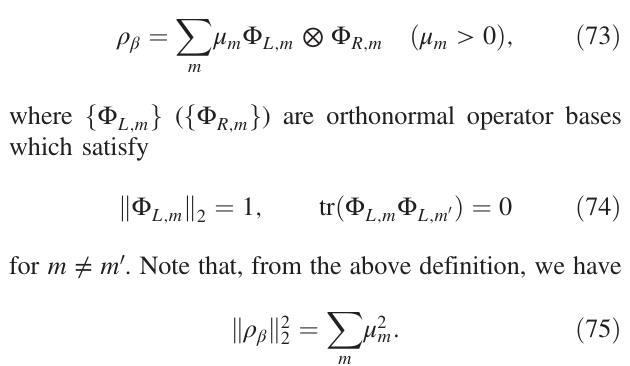
ffiffiffiffiffiffiffiffiffiffiffiffi 20 n ϵ